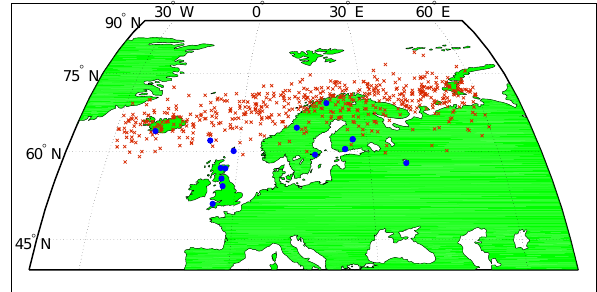
Fig. 1. Map showing the location of SAMNET stations used in this study (blue circles), and the location of the 553 substorm onsets (red crosses) as determined by the IMAGE-FUV satellite. (Geographic latitudes).